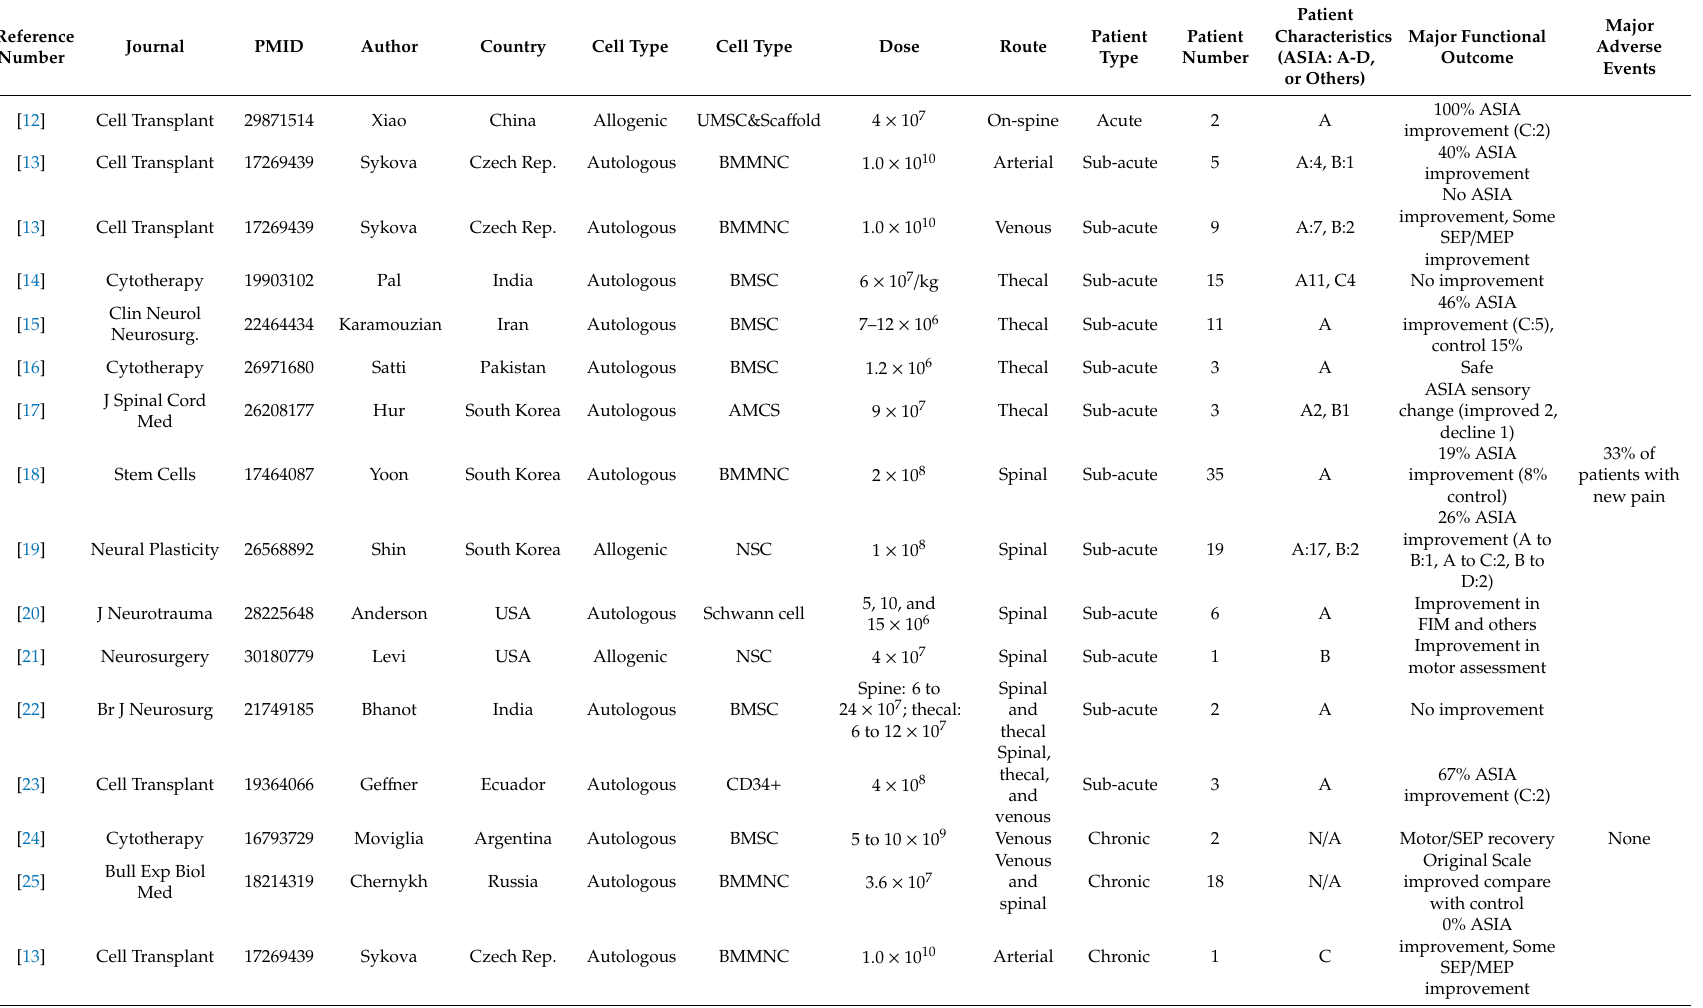
Table 1. List of published clinical